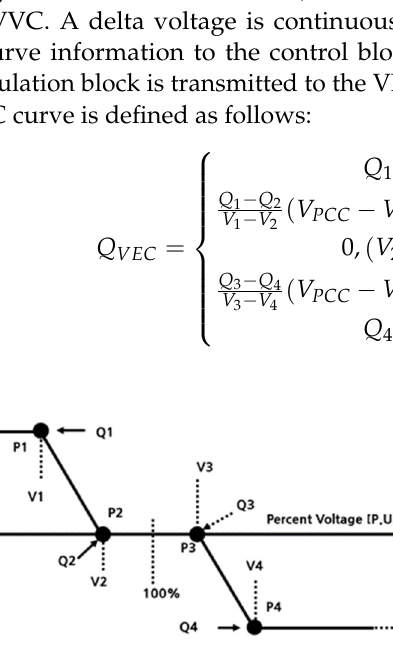
Figure 6. Illustration of the voltage error compensation curve.